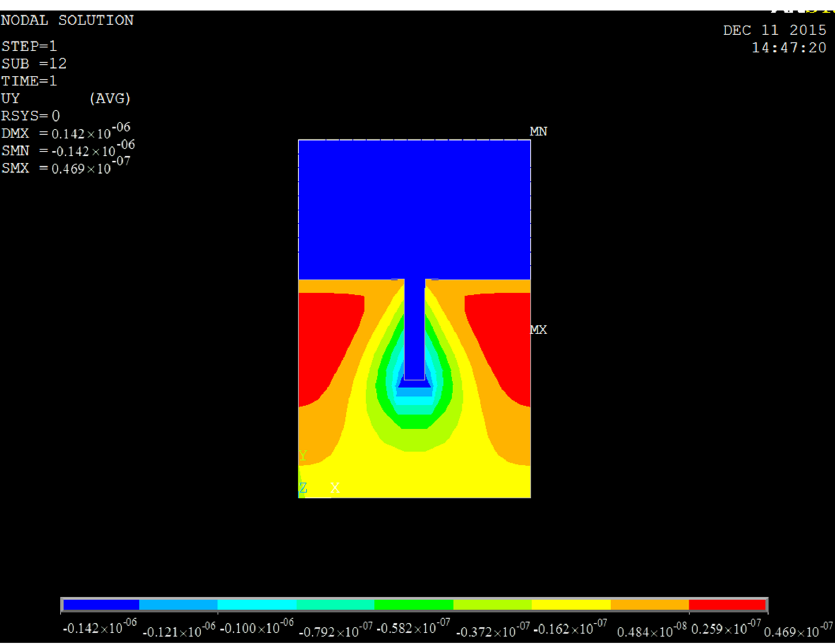
Figure 3. Displacement of a positive mold with an aspect ratio of 5:1, and the corresponding resist.